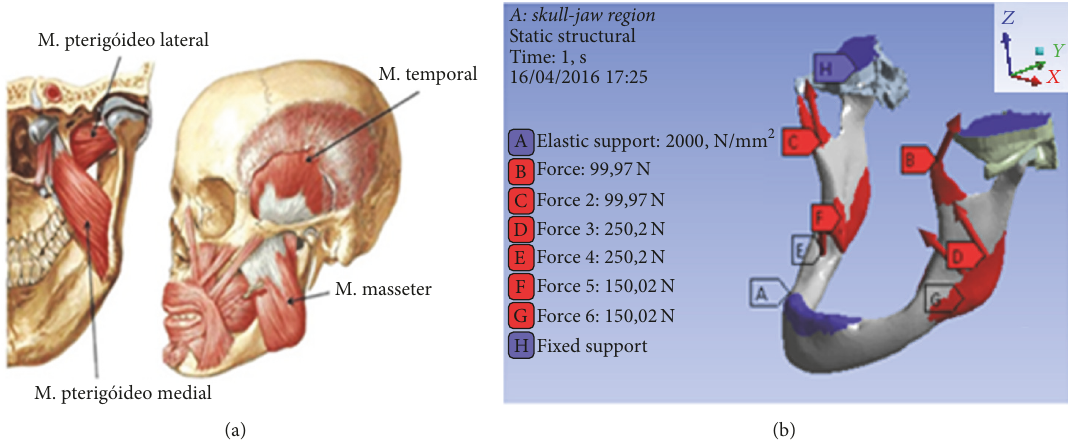
Figure 4: Main muscles of mastication in (a) and boundary conditions applied to the virtual model (b). Source: adapted from Sobotta and Reinhard